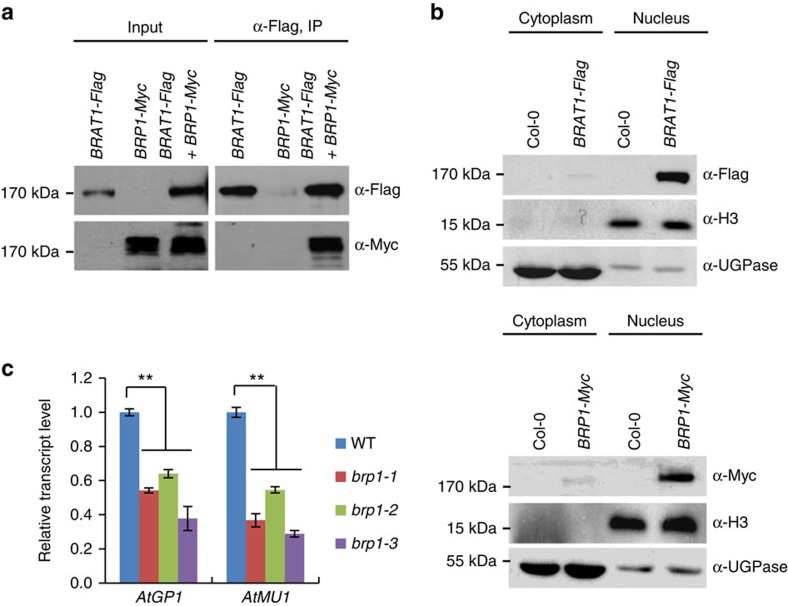
BRAT1 associates with BRP1 and both are involved in transcriptional anti-silencing.(a) The interaction between BRAT1-Flag and BRP1-Myc as determined by co-IP. BRAT1-Flag transgenic plants were crossed to BRP1-Myc transgenic plants, and the F2 lines expressing both fusion proteins were subjected to co-IP. (b) The cytoplasmic and nuclear fractions of wild-type and transgenic seedlings were analysed by western blotting with histone H3 (nuclear marker), UGPase (cytoplasmic marker), Flag and Myc antibodies. Protein size markers are indicated in kDa. (c) The RNA transcripts of AtGP1 and AtMU1 were detected by quantitative RT–PCR in the wild type and three individual brp1 mutant alleles. Asterisks indicate statistical significance as determined by Student's t-test (**P<0.01). ACT7 was amplified as an internal control. Error bars represent s.d. of three biological replicates.